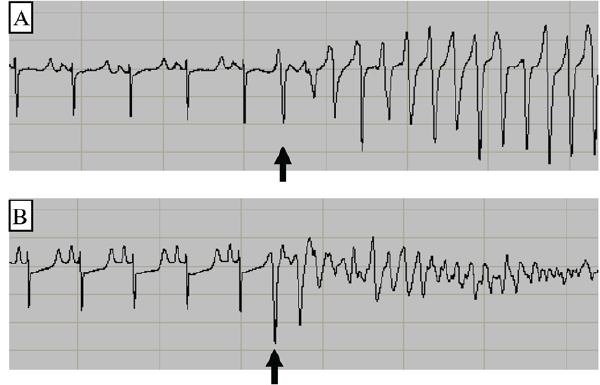
Figure 5. PVC-initiation of arrhythmias. Panel A shows a PVC initiated self-terminating ventricular tachycardia while panel B shows a PVC-initiated ventricular fibrillation. The arrows show the arrhythmia- initiating PVCs falling on the previous T-wave.